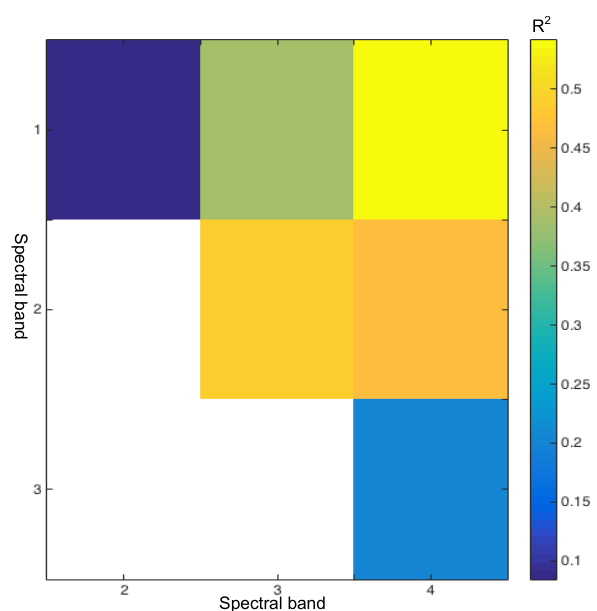
Figure 4. Optimal Band Ratio Analysis (OBRA) using GeoEye image